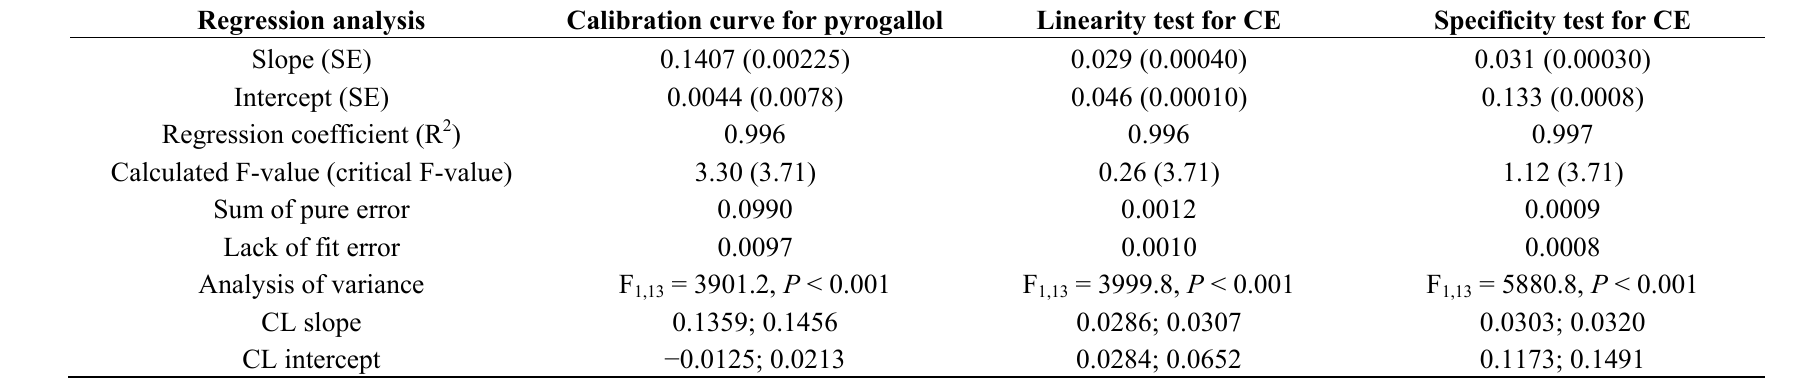
Table 1. Statistical data for the regression equations of the calibration curve for pyrogallol, and linearity test and specificity test for TP of CE from L. brasiliense